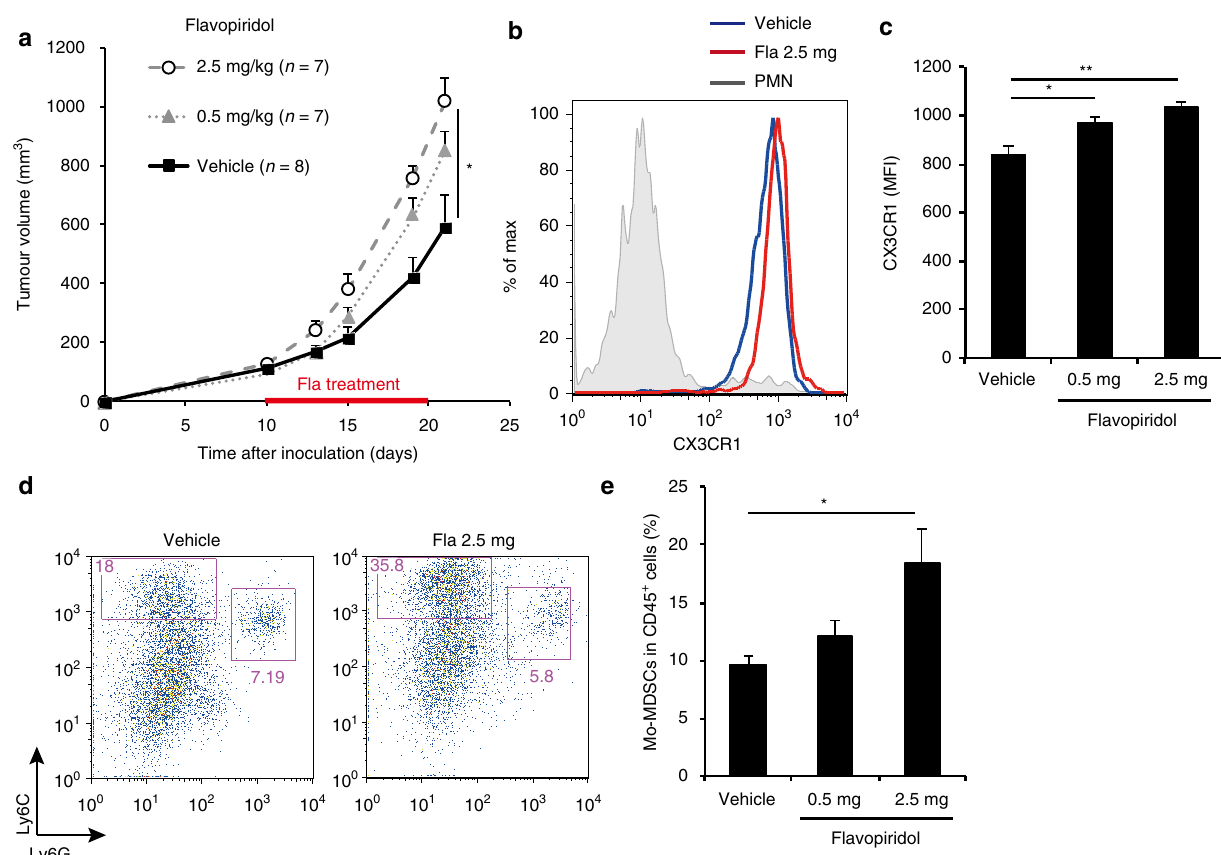
Fig. 6 Flavopiridol accelerates tumour growth in vivo . a SCT growth curve in WT mice administered fl avopiridol (2.5 or 0.5 mg/kg) or vehicle (control) once daily, from day 10 to day 20. b Representative fl ow cytometry histograms showing CX3CR1 expression in splenic Mo-MDSCs from WT mice 10 days after fl avopiridol administration. c Mean fl uorescence intensity (MFI) of CX3CR1 expression shown in b ( n = 4). d Representative fl ow cytometry plots of CD45 + CD11b + -gated cells in tumours from WT mice after fl avopiridol administration; cells were labelled with CD45, CD11b, Ly6C and Ly6G antibodies. e Fraction of CD11b + Ly6C high Ly6G − cells among CD45 + -gated cells shown in d ( n = 5). Data are presented as the mean ± SEM. The statistical signi fi cance was determined by Student ’ s t- test; * p < 0.05 and ** p <